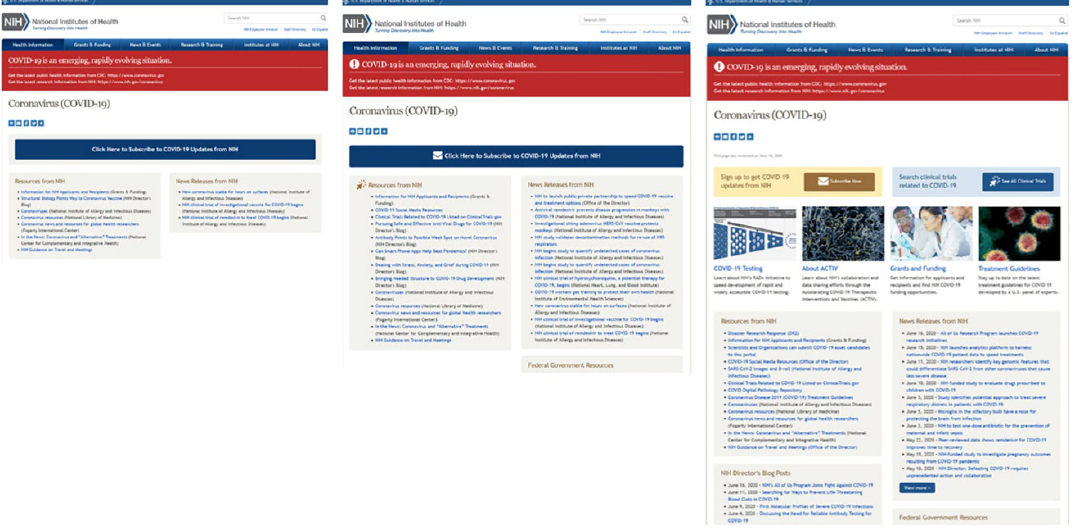
The archive of captures of the National Institutes of Health (NIH) coronavirus (COVID-19) website is available at <https://wayback.archive-